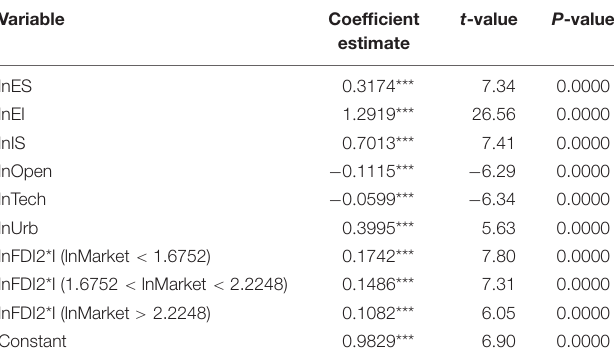
TABLE 8 | Regression results of double threshold